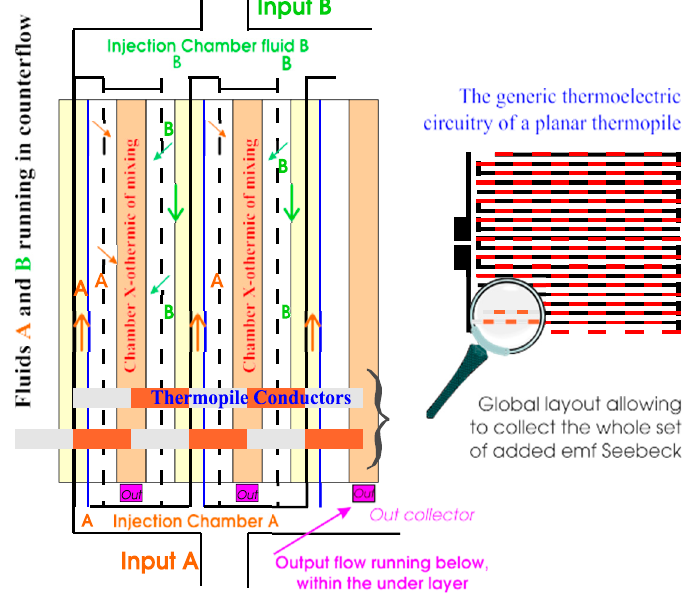
Figure 2. Main principles for constitutive parts of the self-generating microsystem (Zout < 2 k Ω